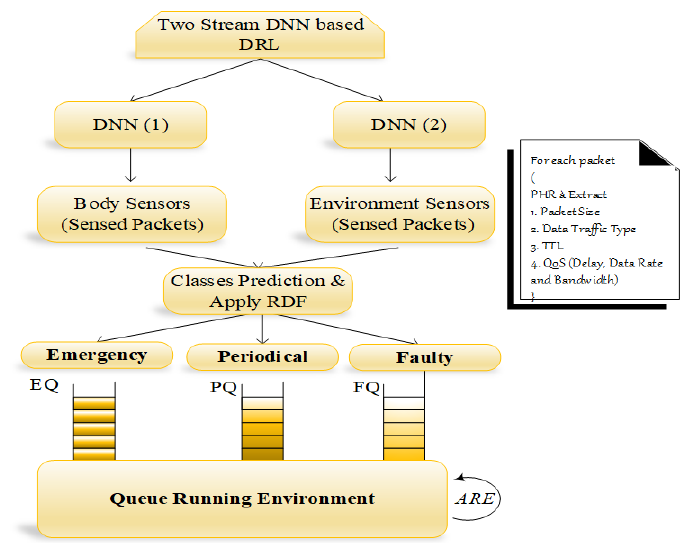
Figure 3. TS-DNN